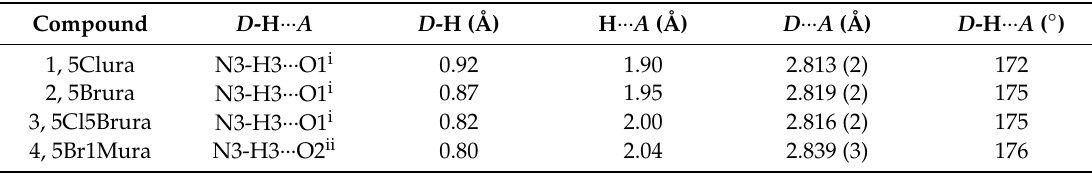
Table 2. Hydrogen-bond geometries for compounds